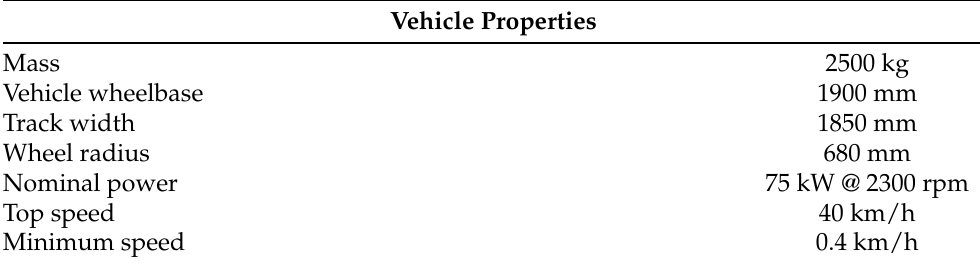
Table 1. Main characteristics of the orchard